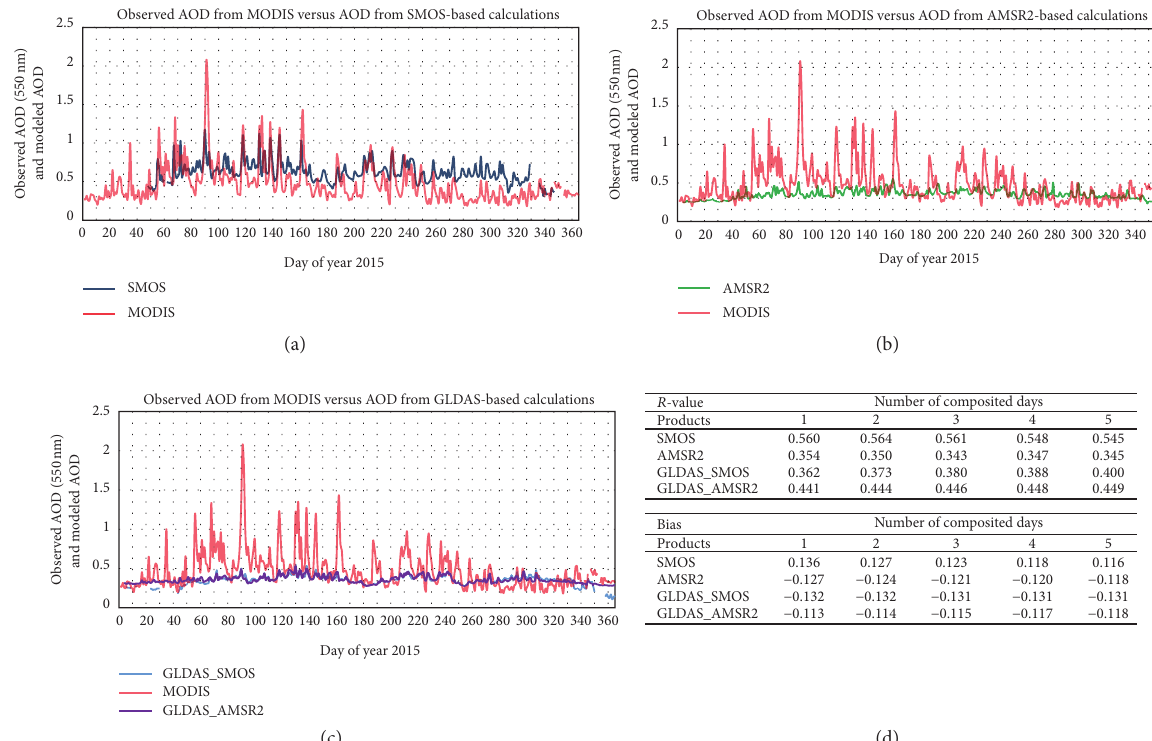
Figure 5: Temporal pattern of observed AOD from MODIS and modeled AOD (exponential model based on SMOS, AMSR2, and GLDAS soil moisture and GLDAS wind speed product) for the year 2015. (a) Observed AOD versus modeled AOD based on SMOS soil moisture, (b) observed AOD versus modeled AOD based on AMSR2 soil moisture model, (c) observed AOD versus modeled AOD based on GLDAS soil moisture products after matching UTC time with local times of SMOS and AMSR2, and (d) statistical comparison of 1 ∼ 5 days composite soil moisture models AOD with observed AOD from MODIS.